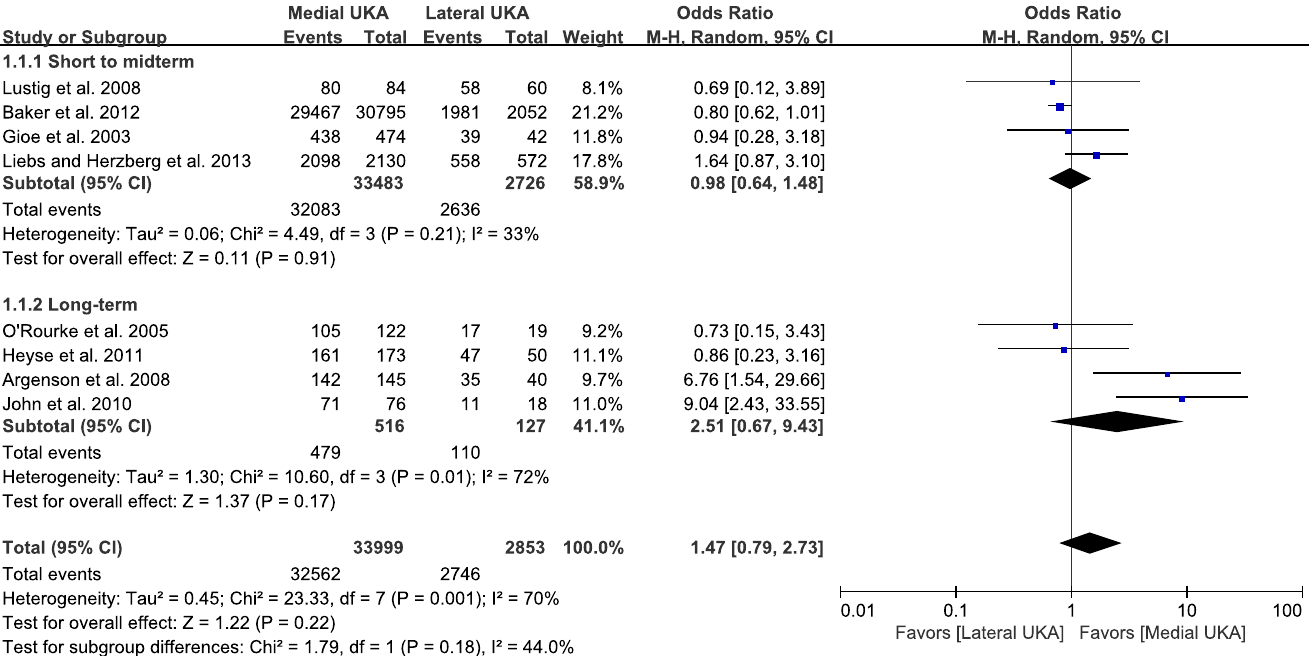
Fig 2. Results of aggregate analysis for comparison of short- to mid-term and long-term implant survival rates between patients with medial and lateral UKAs.